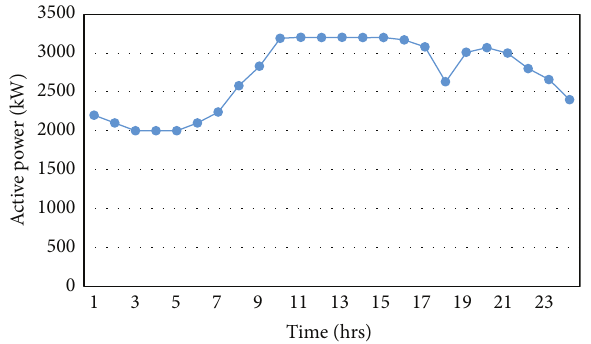
Figure 3: Typical daily load demand profile.